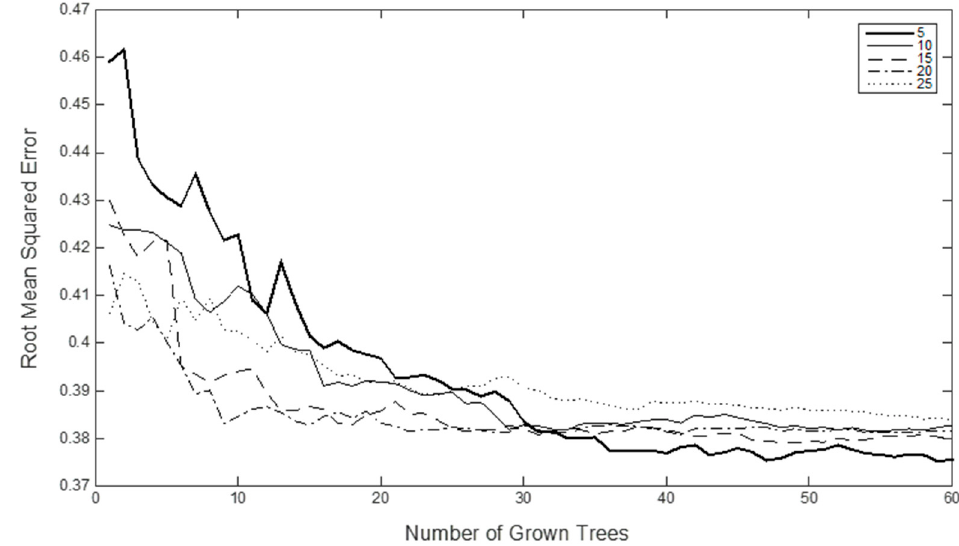
Figure 2. Out-of-bag root mean square error (RMSE) of underpricing prediction vs. the number of grown trees for five different leaf sizes. Experiments were conducted on the training set.